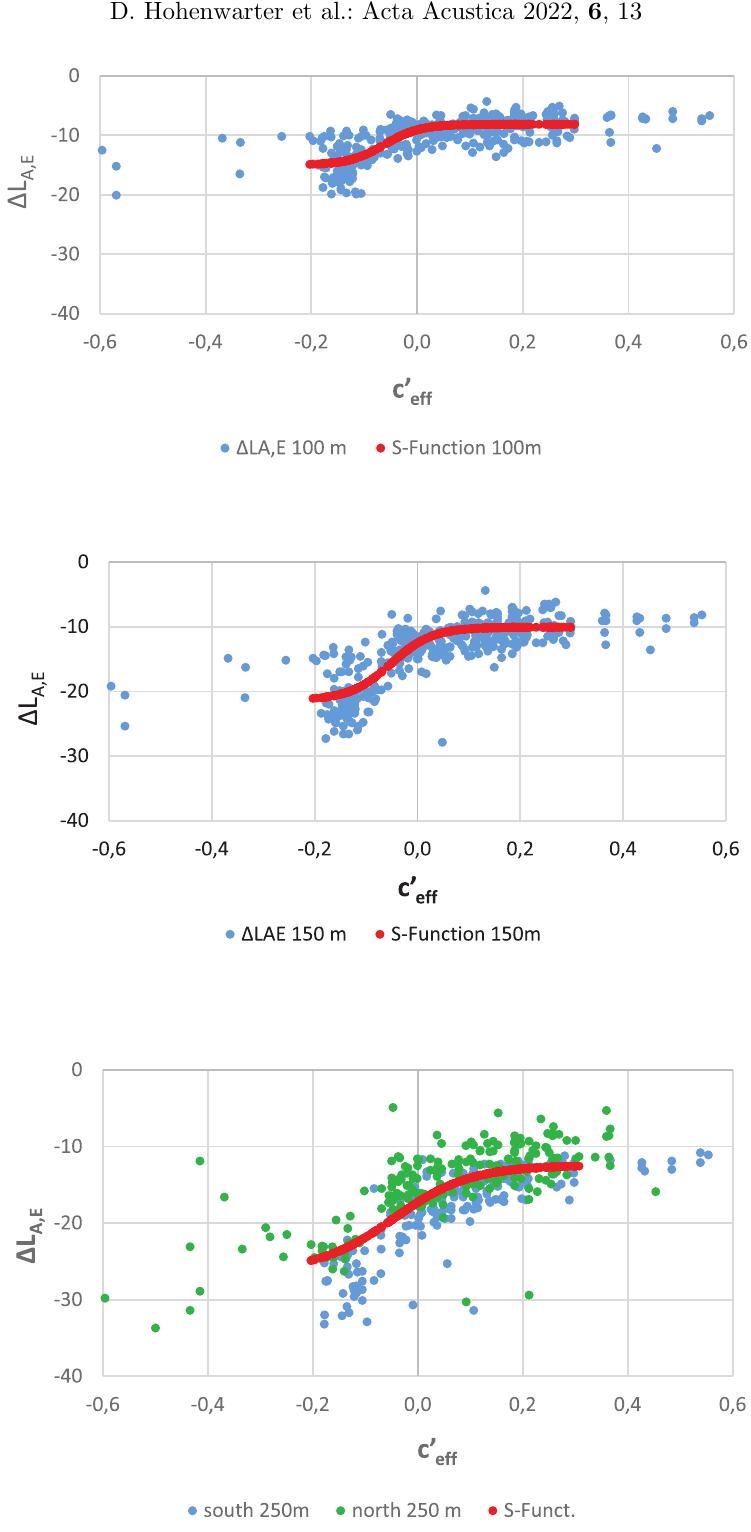
Figure 11. Aderklaa: Sound exposure level difference D L A , E versus effective sound speed gradient for different distances from the railway line with calculated S-shaped